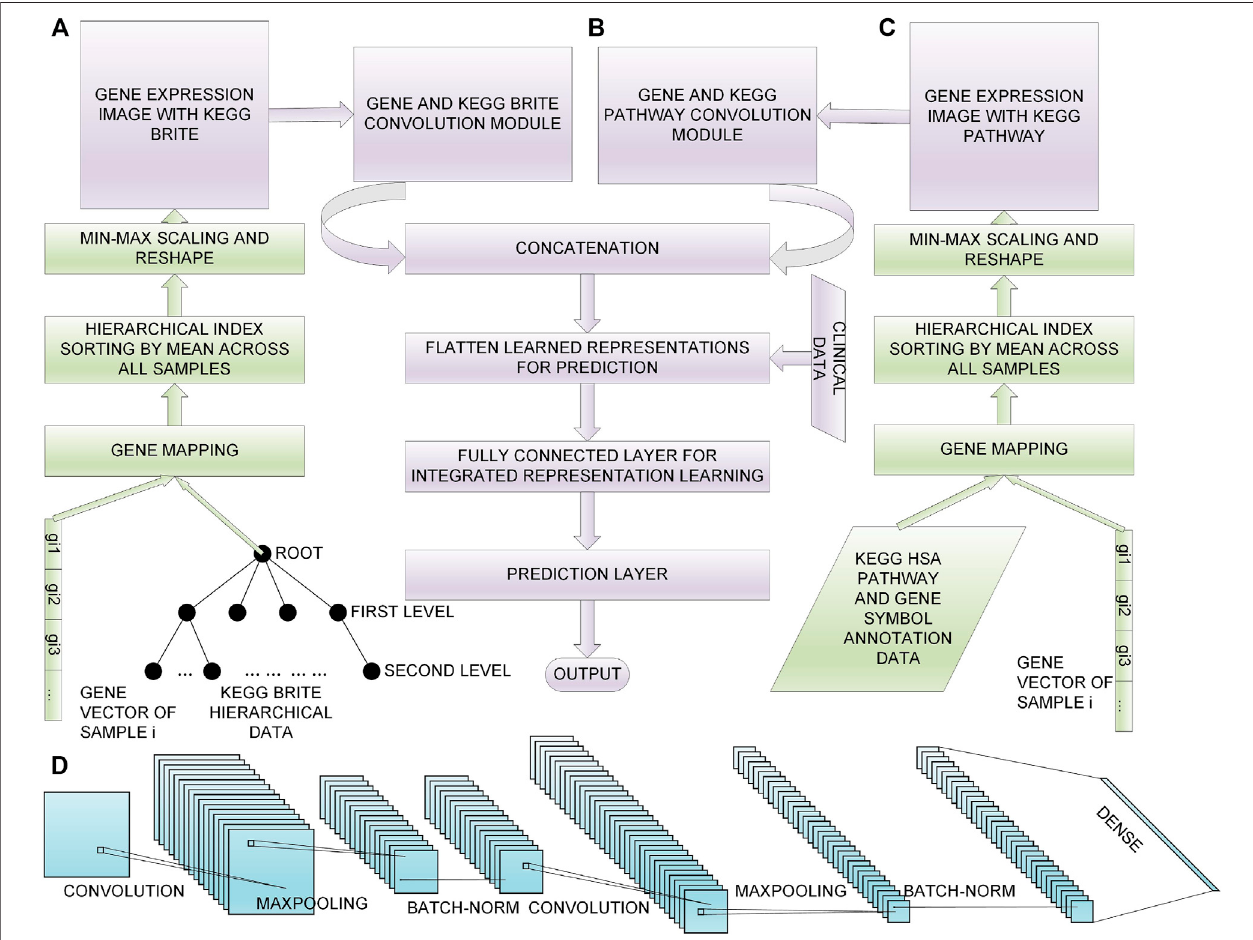
FIGURE 1 | Overall process of the lung cancer long-term survival prediction: (A) the process of generating the gene expression image with KEGG BRITE data, (B) theDLmodelweproposeforthepredictiontask, (C) theprocessofgeneratingthegeneexpression image withKEGGPathwaydata, (D) thedetailed architecture ofthe convolution module we design for learning representations from the gene expression